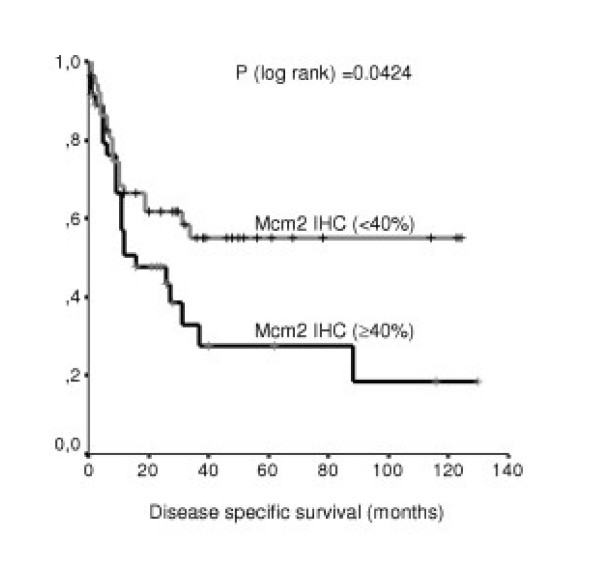
Disease specific survival. Distribution of time (months) to DLBCL-related deaths among patients with negative (<40 % of tumour cells) (n = 52) and positive (≥40% of tumour cells) (n = 36) expression of Mcm2 (Kaplan-Meier method). (IHC = immunohistochemistry)